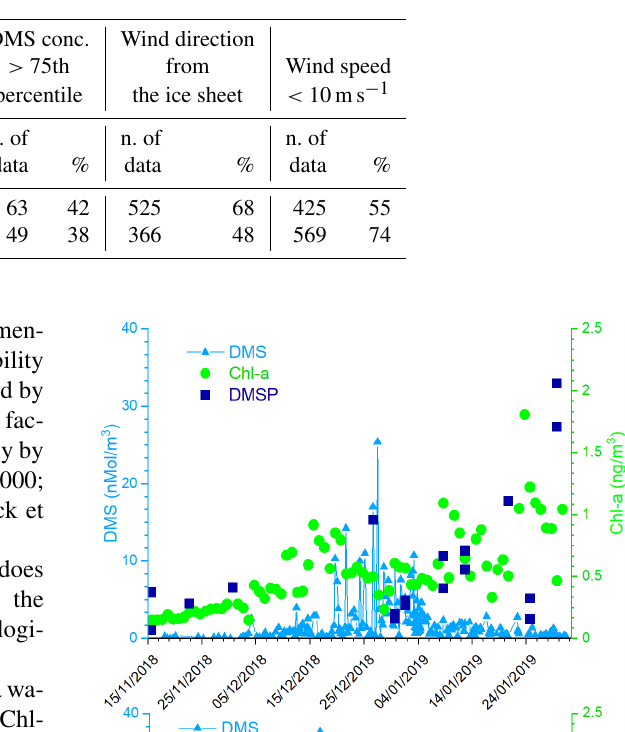
Table 2. Number of data and percentage of DMS concentrations higher than the 75th percentile, wind direction from the ice sheet and wind speed lower than 10ms − 1 .